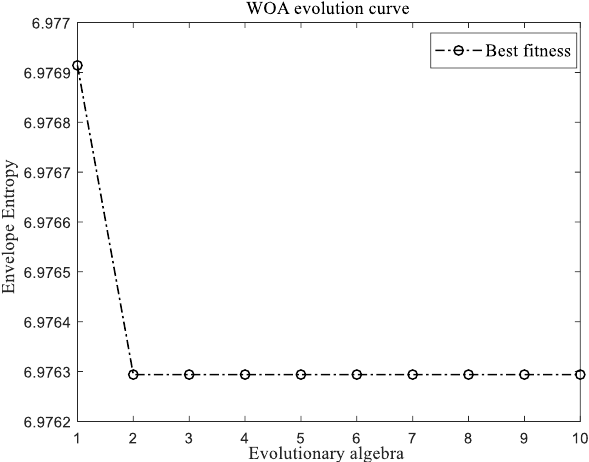
Figure 2. Change of fitness value in the B5 battery.